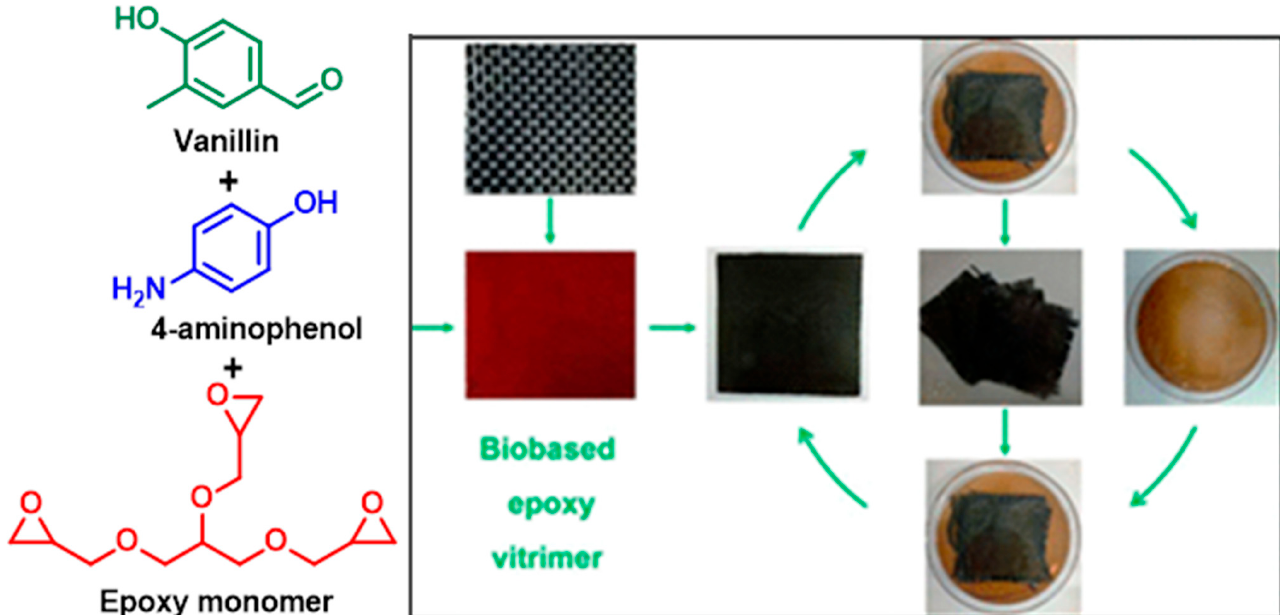
Figure 15. Synthesis way of vanillin-modified vitrimer and full recycling of carbon fiber reinforced composite (CFRP) [reproduced with permission from Liu et al.; published by ACS, 2021] [78].